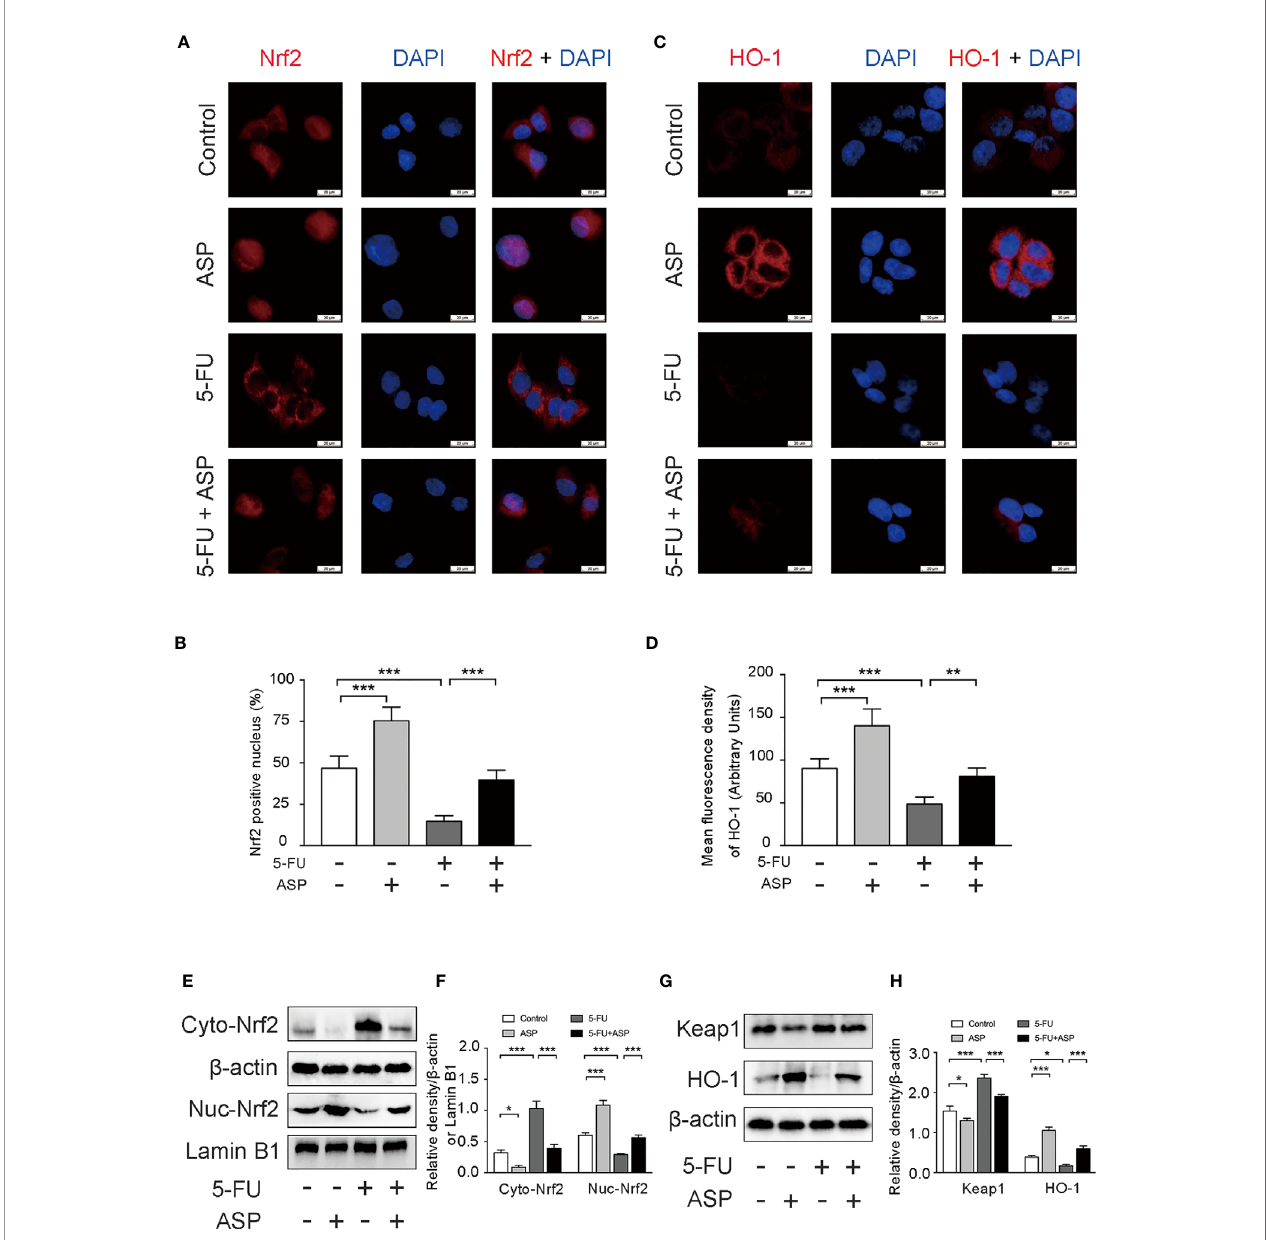
FIGURE 7 | ASP rescued the inhibition of the Keap1- Nrf2 pathway caused by 5-FU in vitro. (A) The nuclear translocation of Nrf2 was detected by immuno fl uorescence (IF) method, with Nrf2 antibody (red) and DAPI staining of the nucleus (blue) (magni fi cation, × 400, scale bar, 20 m m). (B) Quantitative results of the percentage of Nrf2-positive nuclei in the cells. (C) The immuno fl uorescence results showed that ASP alleviated the inhibition of HO-1 activity caused by 5-FU in cells (magni fi cation, × 400, scale bar, 20 m m). (D) The mean fl uorescence intensity of HO-1 was quanti fi ed ( n = 6/group). (E – H) Western blot assay was used to detect the cytoplasmic and nuclear levels of Nrf2 and the protein expression levels of Keap1 and HO-1 in the cells ( n = 3/group). The intensity of the bands was calculated using ImageJ software. b -actin and Lamin B1 (nuclear fraction) served as the internal control. * p < 0.05; ** p < 0.01; *** p <